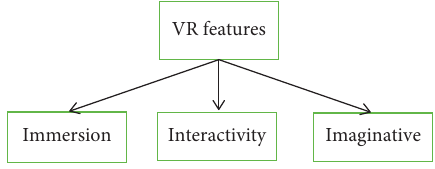
Figure 5: Three characteristics of virtual